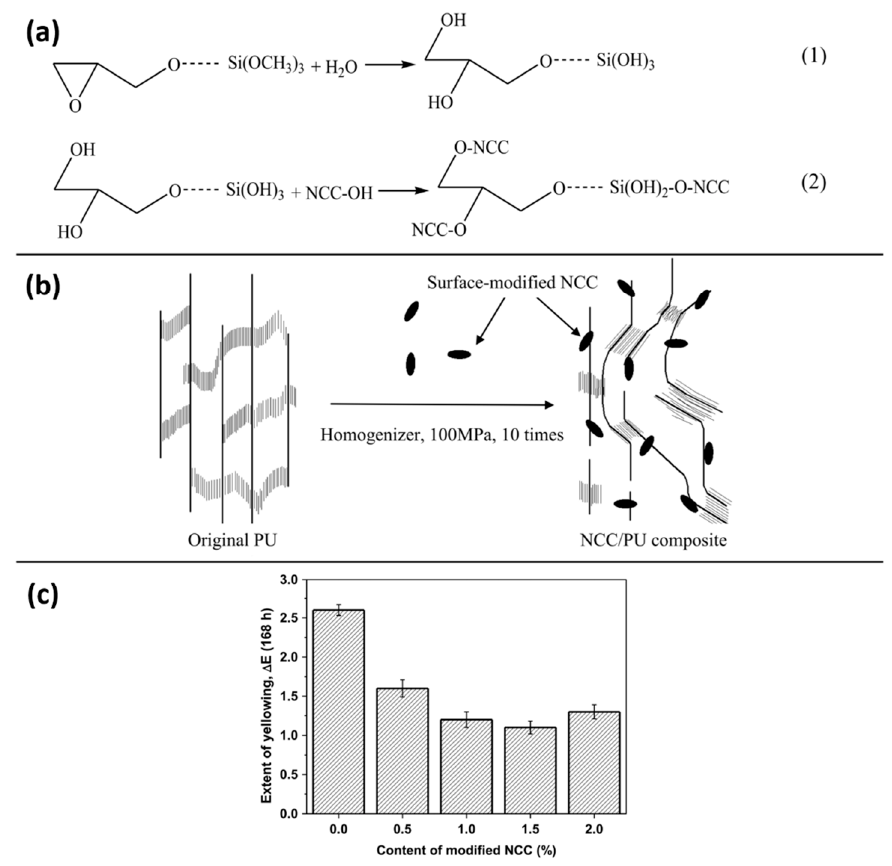
Figure 10. ( a ) reaction scheme for the modification of CNC using 3-Glycidyloxypropyl trimethoxysilane (GPTMS) (reaction scheme 1) and interaction between modified CNC and polyurethane (PU) (reaction scheme 2), ( b ) diagrammatic representation of the dispersion of modified CNC within the PU and ( c ) bar graph showing the effect of concentration of the modified CNC on the yellowing of PU upon exposure to UV radiation over a controlled period of time.